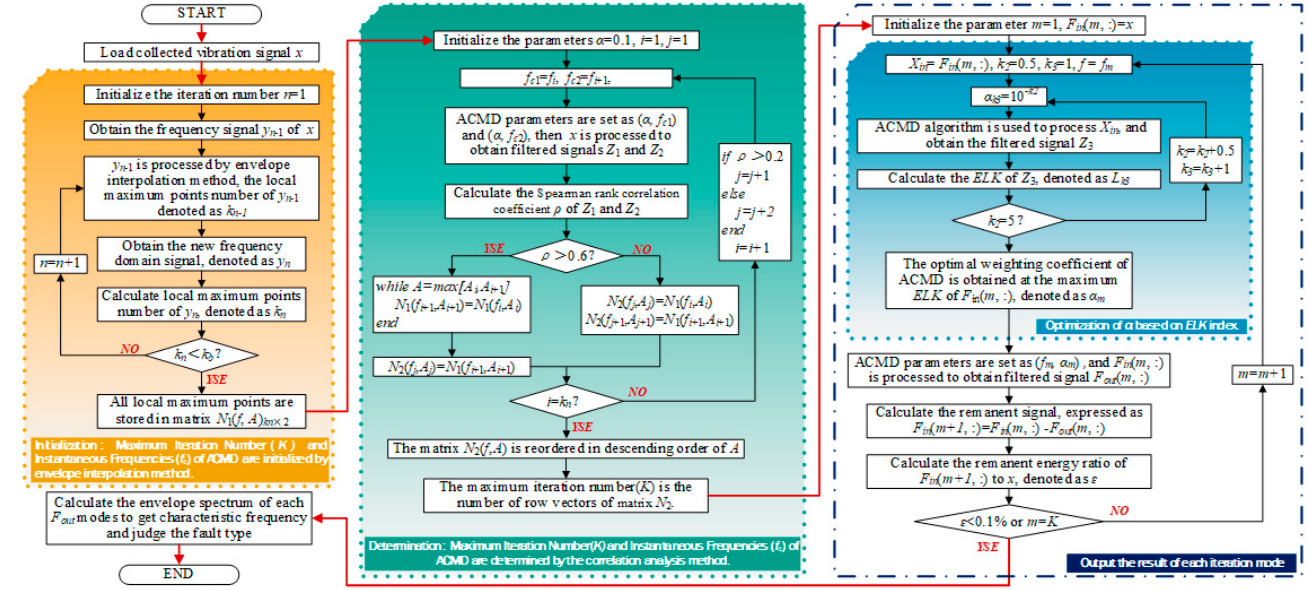
Figure 6. Implementation steps of the proposed IMACMD.